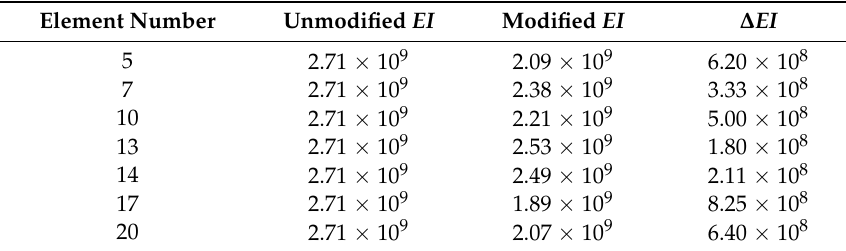
Table 4. Stiffness change of partial unit of undamaged case.